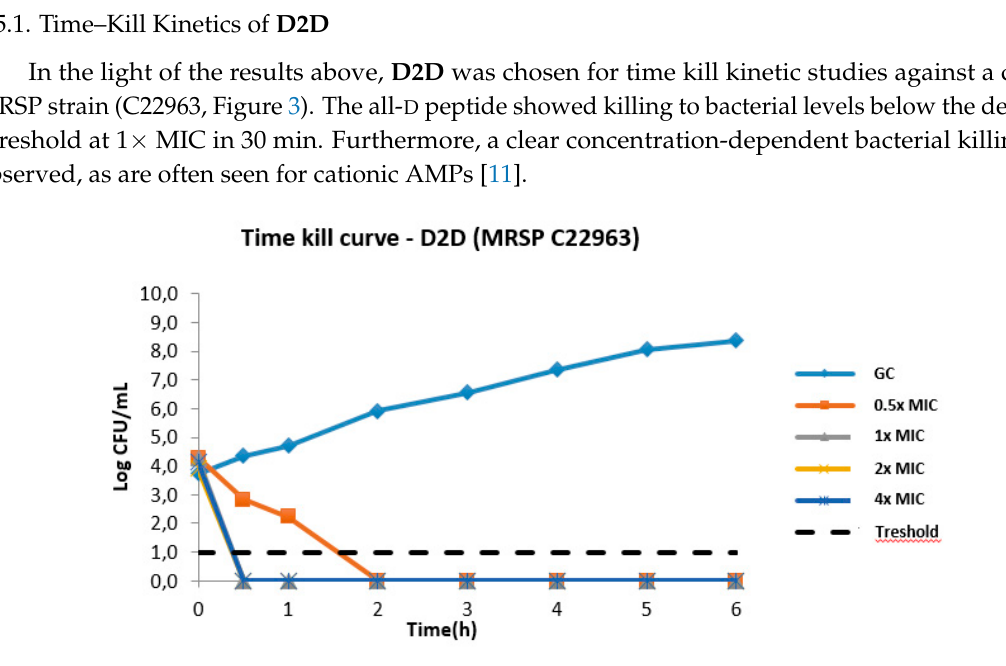
Figure 3. Time–kill curves of D2D , the best candidate analogue identified in this study, against a clinical MRSP isolate (C22963). GC: growth control. We observed regrowth after 24 h (data not